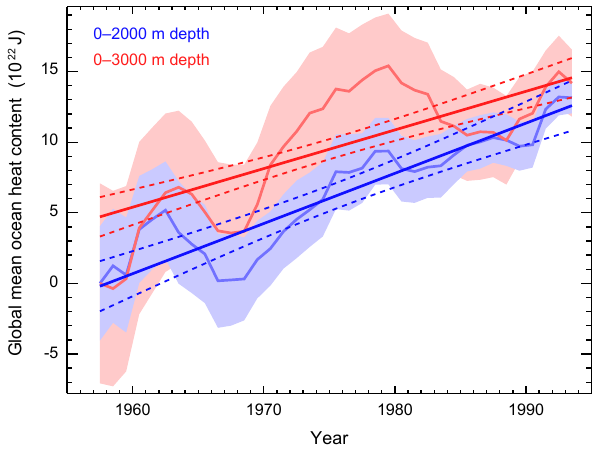
Figure 2. Global mean ocean heat content for the 0–3000m layer (Levitus et al., 2005) and 0–2000m layer (Levitus et al., 2012). Shading indicates twice the standard error on either side of the es- timate. Standard error estimates are included with the time series from the respective datasets. Dashed lines represent the 95% confi- dence interval for the trend line derived from the data and its uncer- tainty